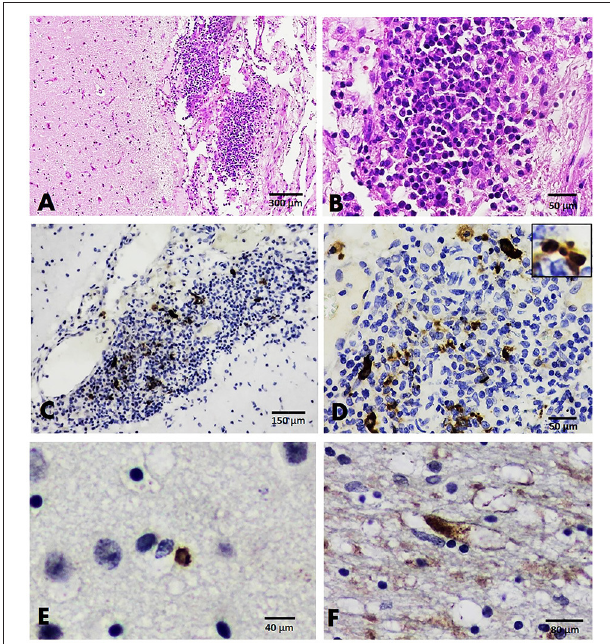
FIGURE 4 | Brain, cat no. B100. (A,B) HandE sections from the FCoV-infected cat revealed the infiltration of inflammatory cells, primarily lymphocytes, and plasma cells, in the meningeal lining of the cerebrum (A,B) . (C,D) IHC staining with double detection of FCoV and FeHV-1 in the brain. Immunoreactivity to FCoV antigen was demonstrated by the inflammatory cells (C,D) . (E,F) Positive immunostaining to the FeHV-1 antigen was expressed by resident cells comprising the gray (E) and white matter of the cerebrum (F) .